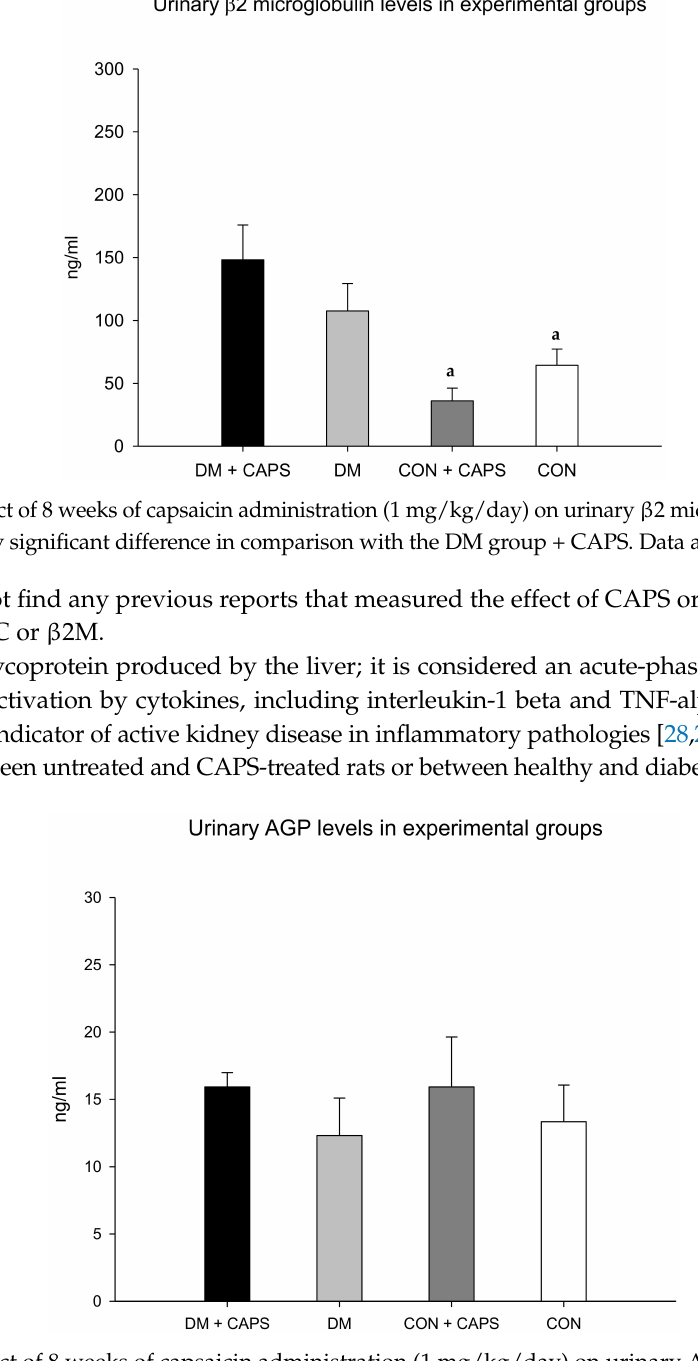
Figure 5. Effect of 8 weeks of capsaicin administration (1 mg/kg/day) on urinary AGP levels. AGP: alpha (1)-acid glycoprotein. Data are mean ±